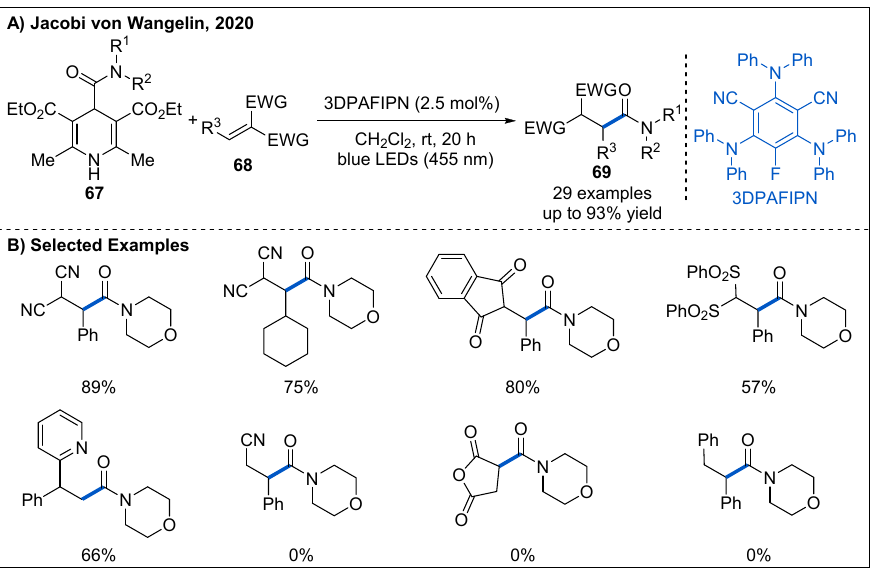
Figure 23. Visible-light-driven photoredox-catalyzed carbamoylation of azomethine imines. By exploiting electron donor − acceptor (EDA) complexes formed between N -ami- dopyridinium salts 73 and 1,4-dihydropyridines 74 , Hong reported a robust route to access